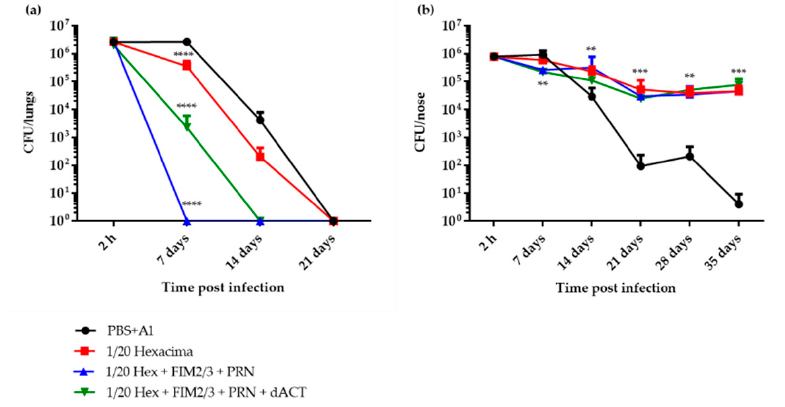
Figure 2. Protection against intranasal B. pertussis challenge in BALB/c mice immunized by 1/20 HD